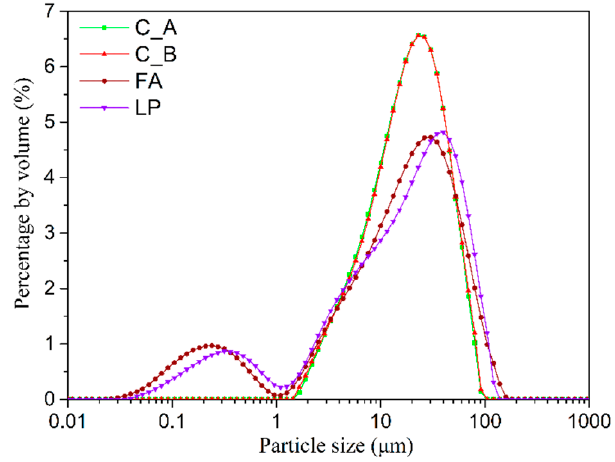
Figure 3. Particle size distribution curves of powders.